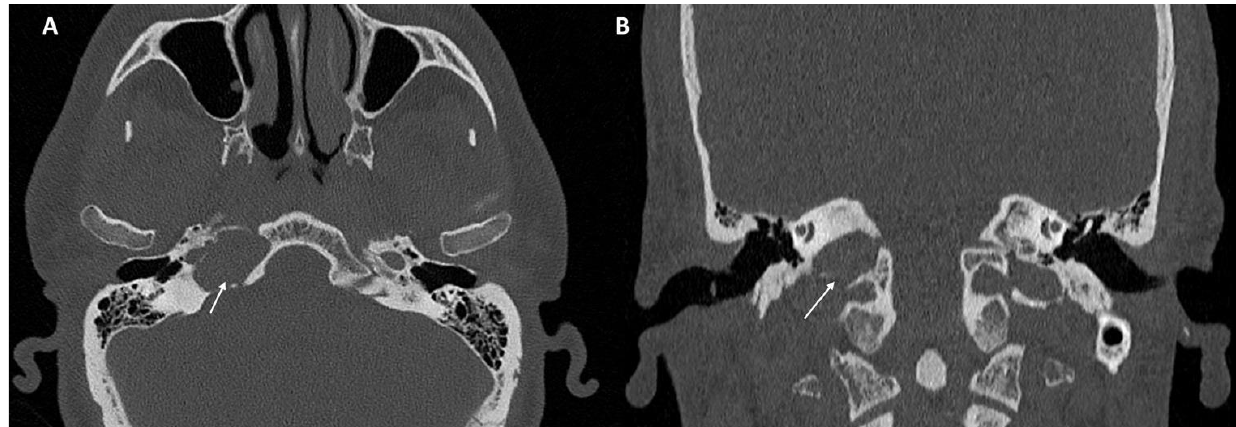
Figure 6. CT scan in the axial ( A ) and coronal ( B ) planes of the jugular tubercle (white arrow) defined as the bony convexity medial to the jugular foramen just above the hypoglossal canal (in axial sections) or the bony part just above the hypoglossal canal (in coronal sections).